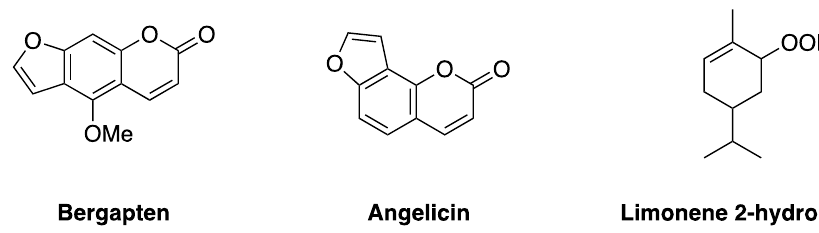
Figure 2. Chemical structures of some furocoumarins and limonene